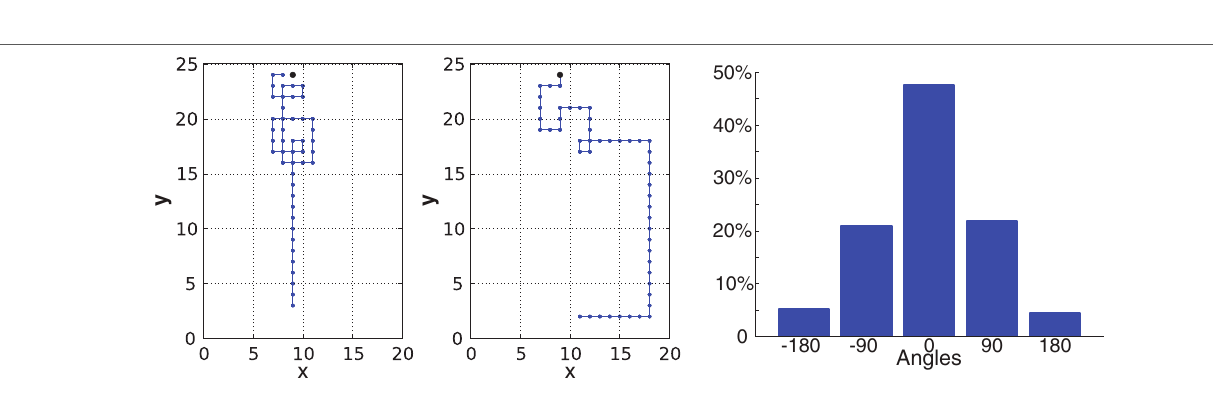
FIGURE 2 | Robot vs simulated infotaxis. Left: Cumulative distributions of the number of detections for robot infotaxis (plain curve) and for simulated infotaxis (dashed curve). Right: Cumulative distributions of the number of steps (search time) for robot infotaxis (plain curve) and for simulated infotaxis (dashed curve).